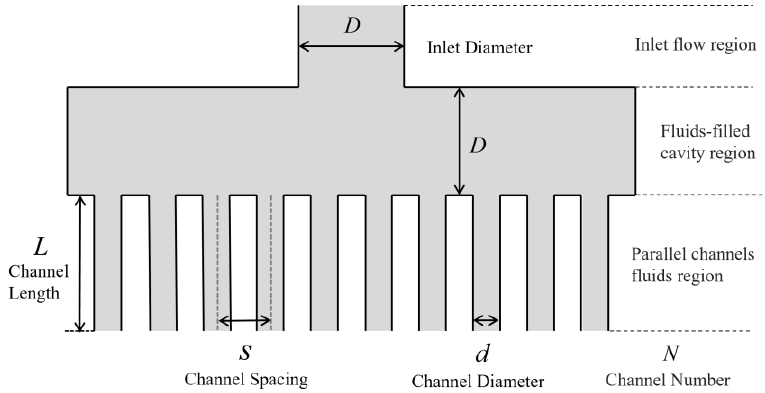
Figure 1. Structure of parallel channels and parameter identification.